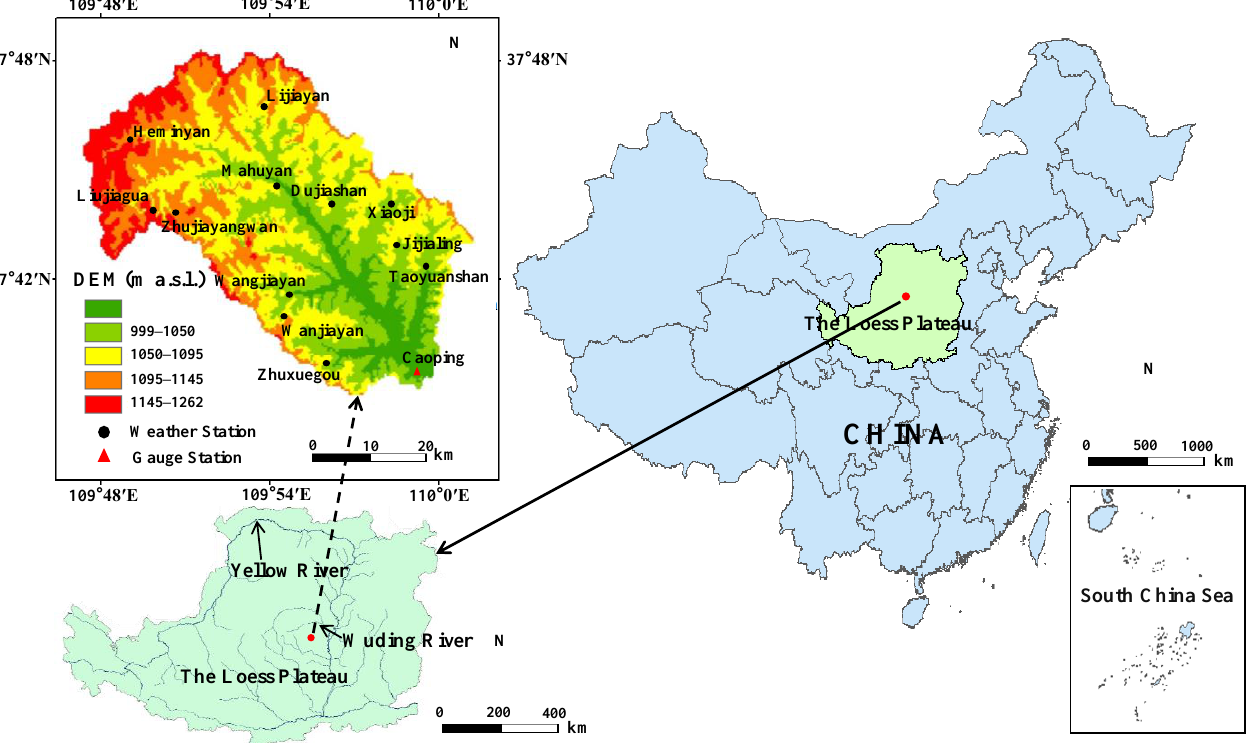
Figure 1. Location of the Chabagou River watershed and analyzed hydrological stations.